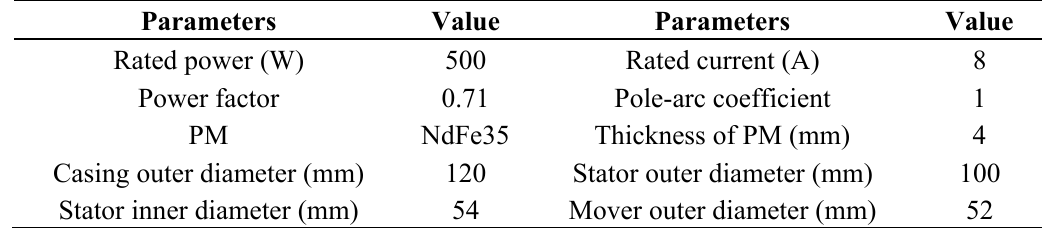
Figure 3. Arrangement of PMs. Table 1. Basic parameters of the transverse-flux permanent-magnet linear machine